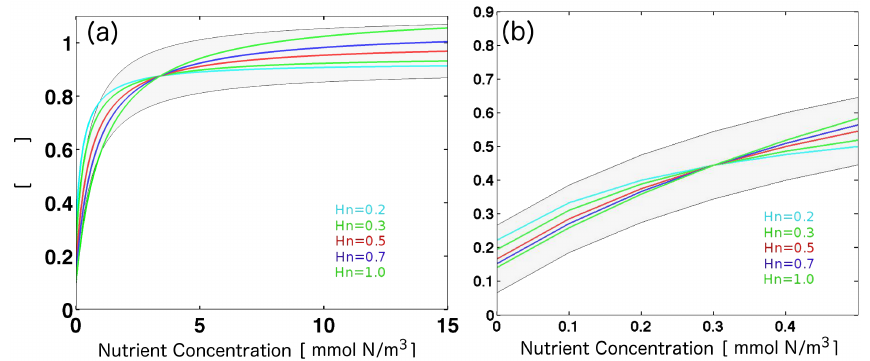
Figure 6. Normalized Michaelis–Menten curves ( α N ) for various half-saturation constants H N , as indicated in the figure legends. The N + H N normalization constant α is chosen such that all curves cross at the same nutrient concentration. Panel (a) and (b) feature nutrient crossover concentrations of 4 and 0 . 3mmolNm − 2 . Shaded areas envelope the H N = 0 . 5 curve by adding a constant value of ± 0 . 1 to this